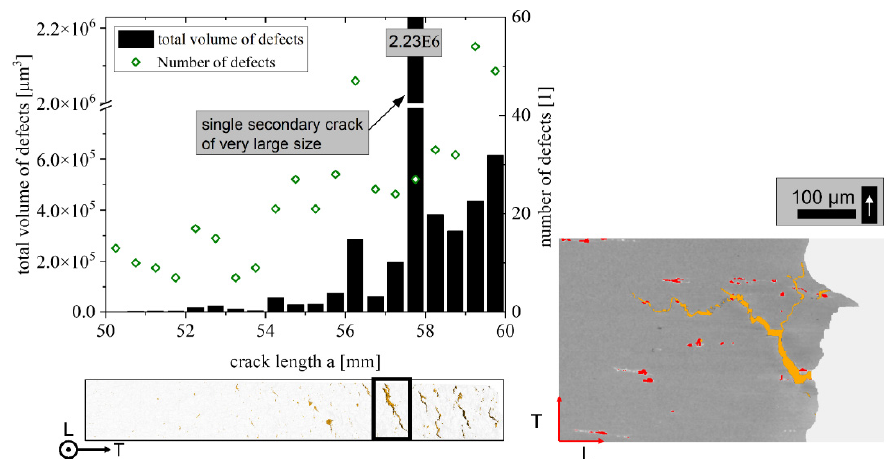
Figure 16. Number and volume of secondary cracks and defects at high crack lengths for var 3.